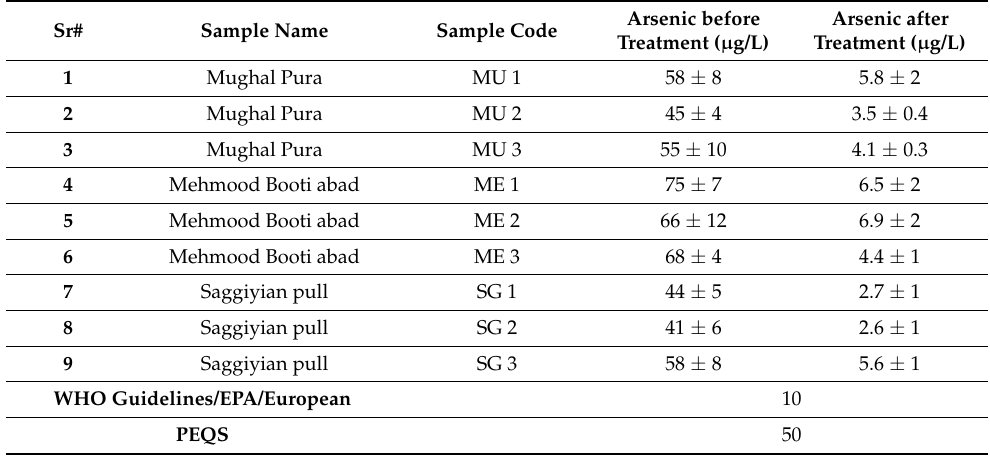
Table 4. Removal of As from nine (9) locations in Lahore through catalytic ozonation